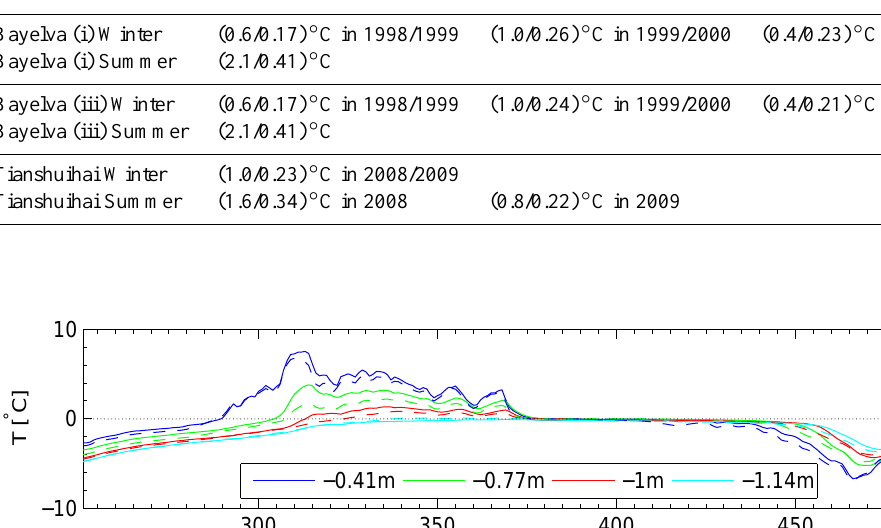
Table 3. (Maximum/root-mean-square (rms)) temperature deviations between simulated and measured data.